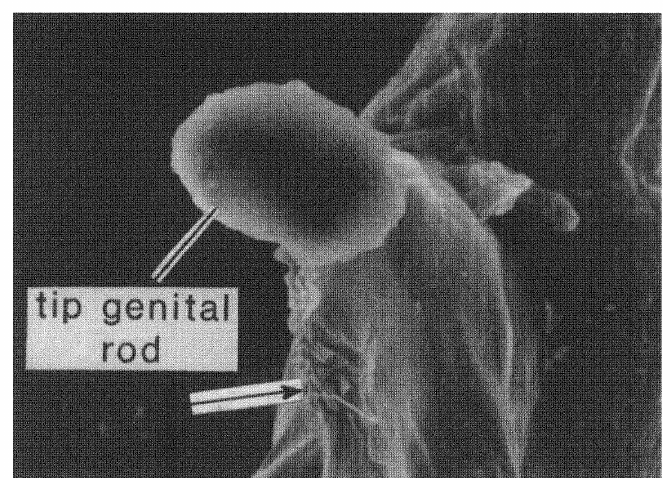
Fig. 6. Scanning electron micrograph of the tip of the genital rod, showing the membrane covering its tip. The arrow indicates the area where sperm may emerge (see Fig. 7).